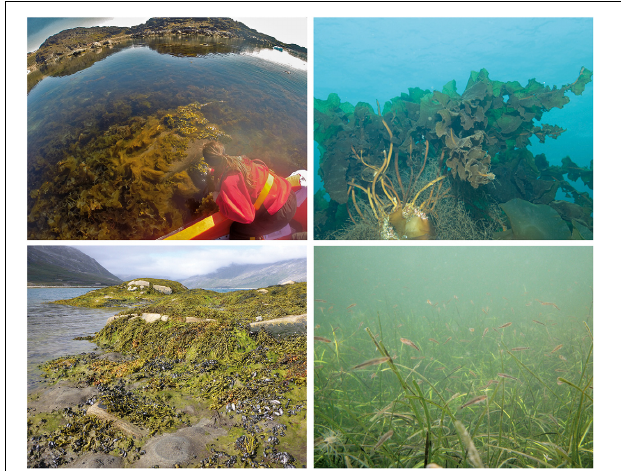
FIGURE 1 | Examples of vegetated coastal habitats in the Arctic. Upper left: Kelp-covered shallow cove dominated by Saccharina latissima , Disko Bay, Greenland (photo: Frida Lindwall). Upper right: Kelp habitat dominated by Saccharina latissimi , Norway’s coast (photo: Stein Frederiksen). Lower left: Intertidal vegetation dominated by knotted wrack ( Ascophyllum nodosum ) and colonized by blue mussel ( Mytilus edulis ), Kobbe Fjord, Nuuk, Greenland (photo: Dorte Krause-Jensen). Lower right: Eelgrass ecosystem, Norway’s coast (photo: Stein Frederiksen).